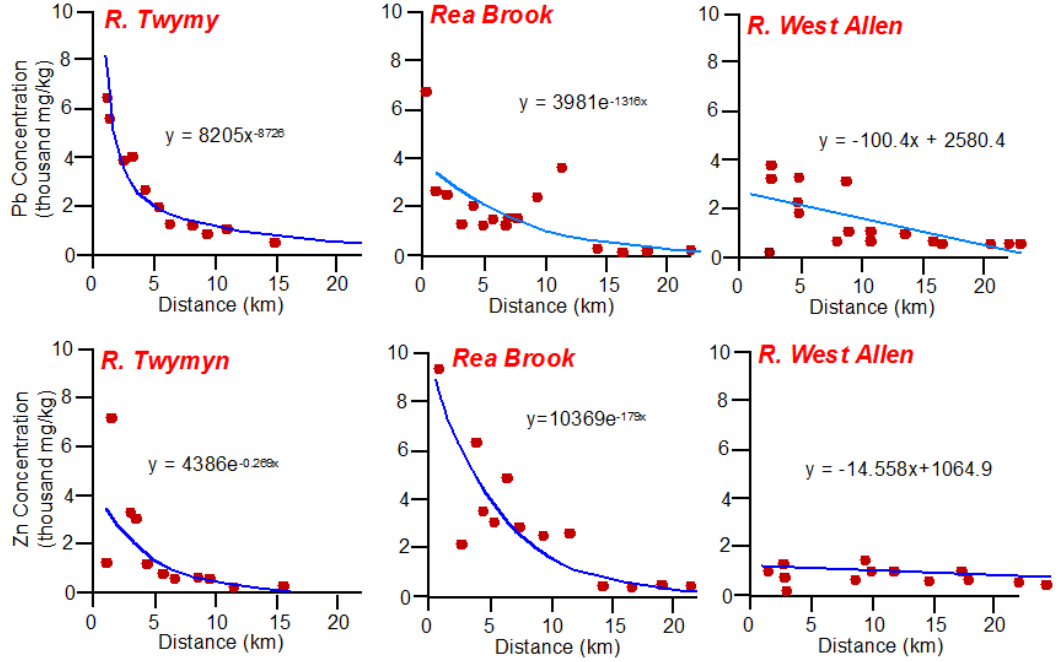
Figure 2. Downstream trends in Pb and Zn concentrations along the River Twymy, Rea Brook and West Allen in the UK. Solid lines represent the best-fit regression models, and show that concentrations tend to semi-systematically decrease downstream of a point source (figure modified from Lewin and Macklin [48] as shown in Miller and Orbock Miller